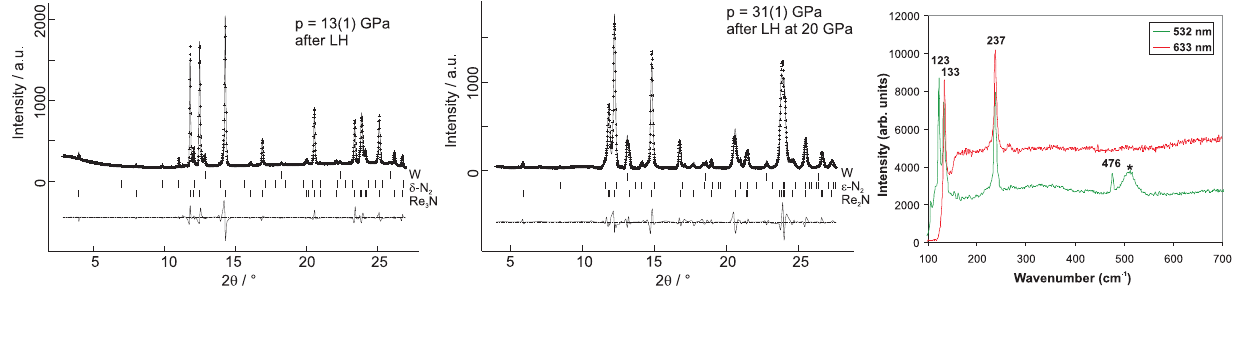
Figure 7. Left and center: Powder X-ray diffraction patterns ( λ = 0.4958 ˚ A) of Re laser heating at 1700(200) K at 13(1) GPa (left), and of Re during laser heating at 20(2) GPa and pressure increase (center) [60]. Diffraction lines of tungsten stem from the gasket. Right: Raman spectra of Re line, 633 nm, 50 mW) and a Nd/YAG laser (bottom line, 532 nm, 20 mW) [61]. The broad band indicated by a star is attributed to